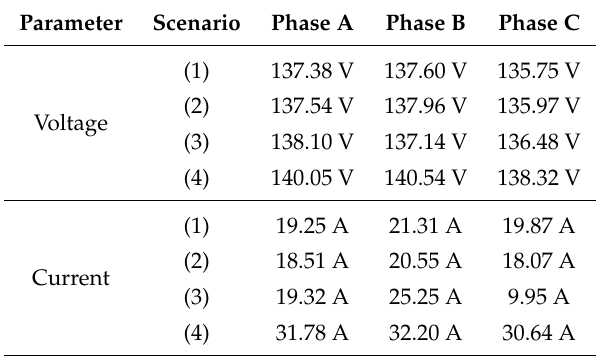
Table 8. Voltage and current Root Mean Square (RMS) values.